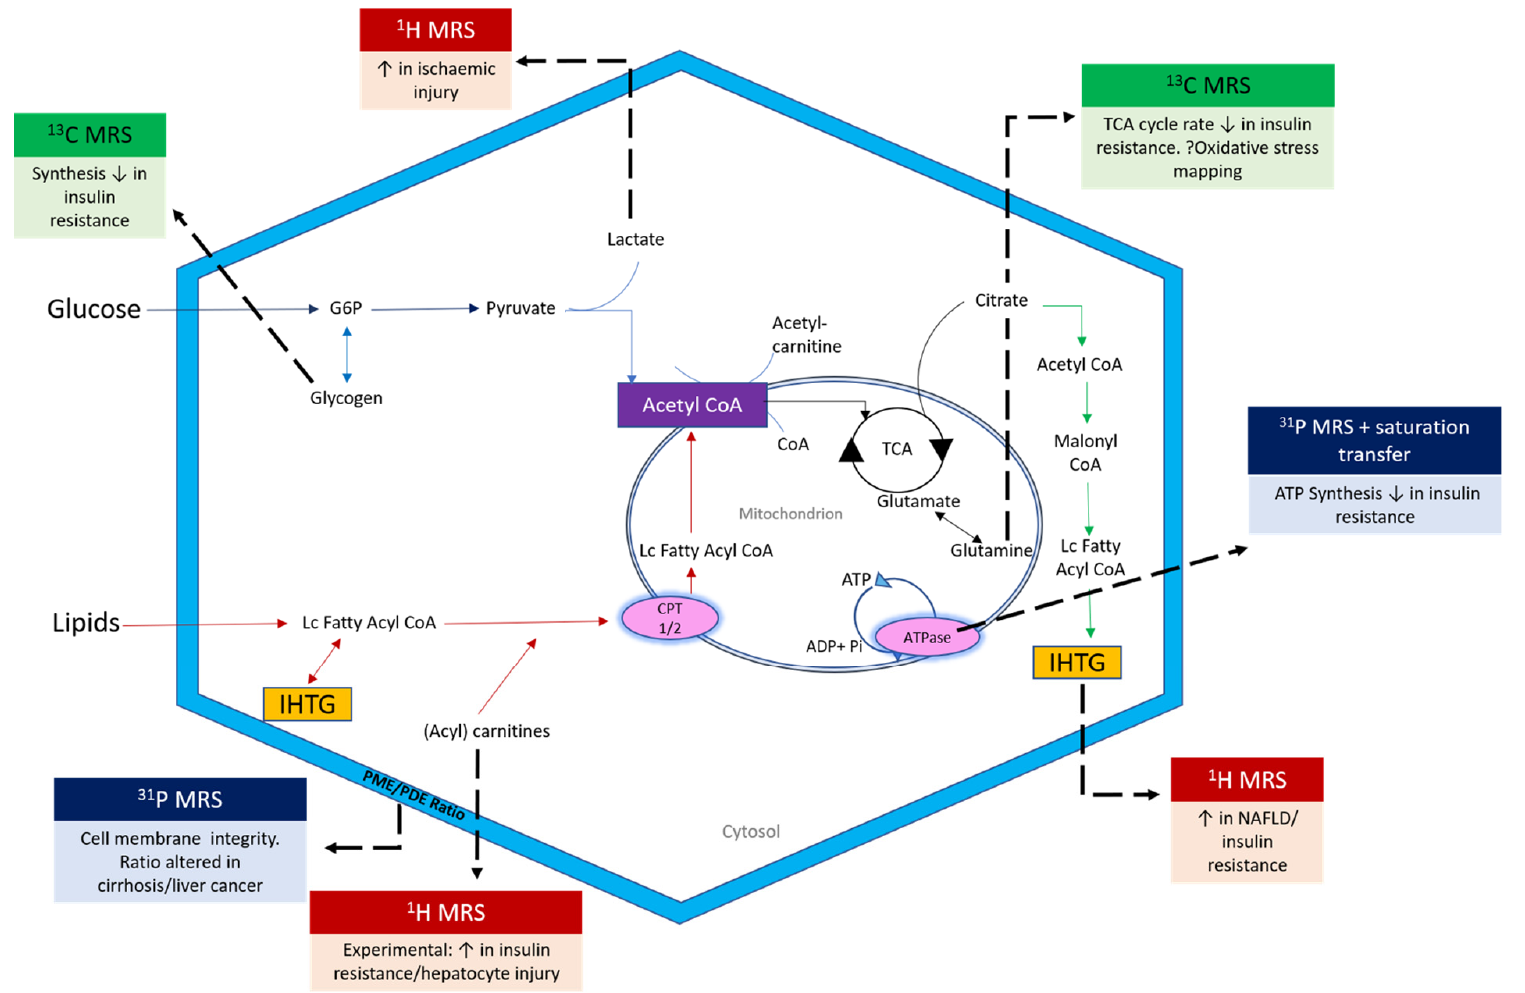
Figure 2. Scope of multinuclear MR Spectroscopy in the interrogation of metabolic liver disease. LC = Long chain; G6P = glucose 6 phosphate; CPT = carnitine palmitoyl transferase; PME = phosphomonoester; PDE = phosphodiester; Pi = inorganic